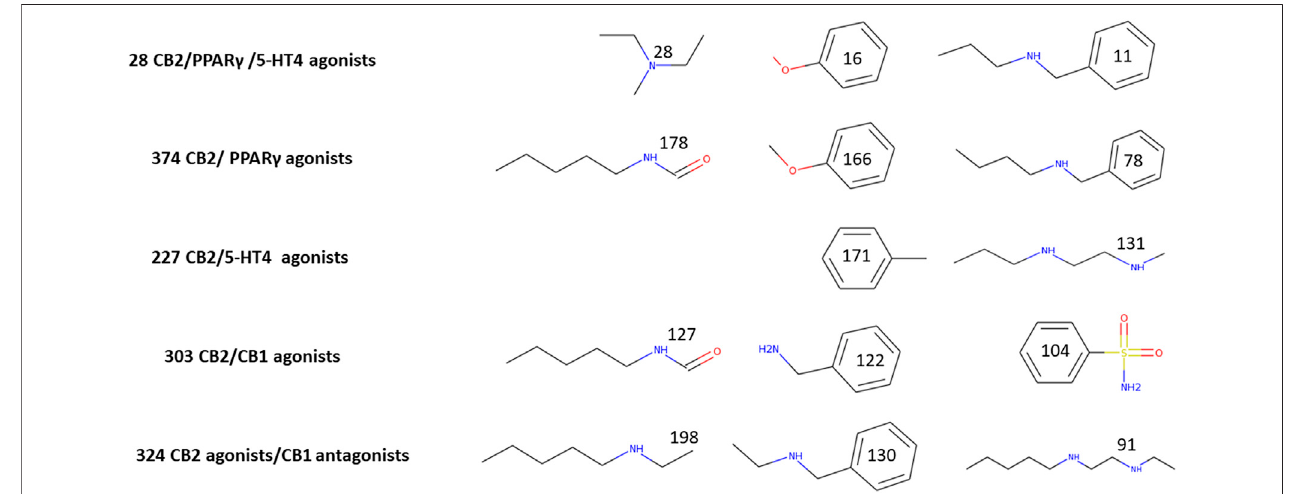
FIGURE 2 | Major common multitargeted substructures. The numbers on each substructure indicate the number of molecules that include it. We chose 303 top candidates (with index score > 0.7) for assigning substructures to CB2R/CB1R agonists and 227 top candidates (Index > 0.7) for the substructures of CB2/5-HT4 agonists. Other substructures were assigned for sets with an index >